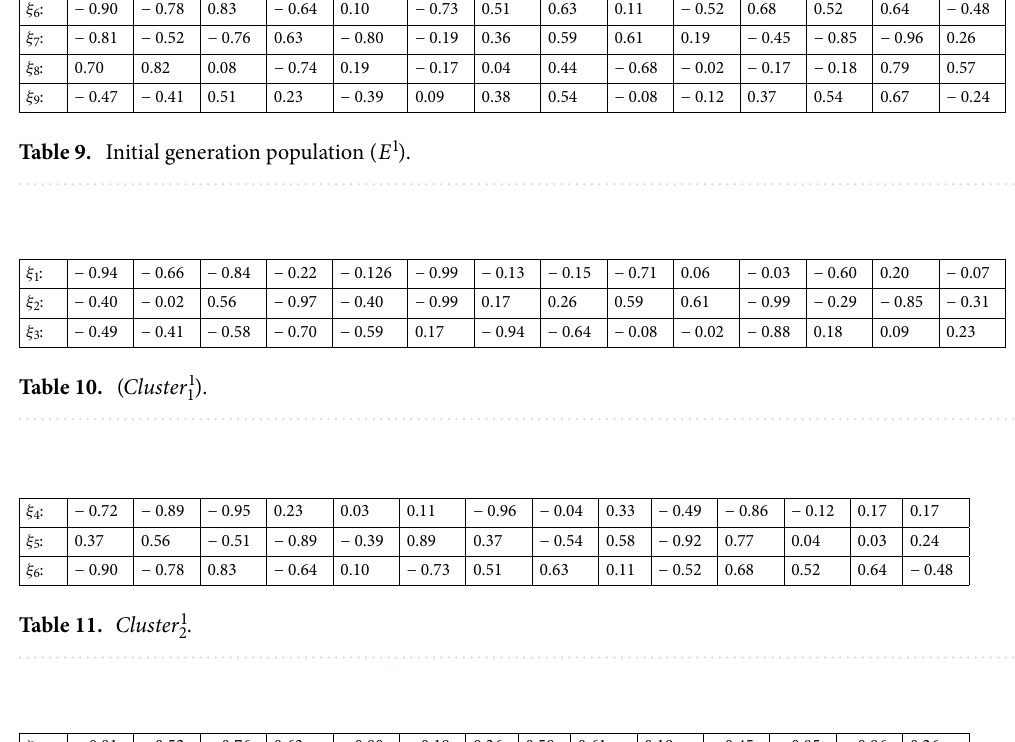
Table 12. Cluster